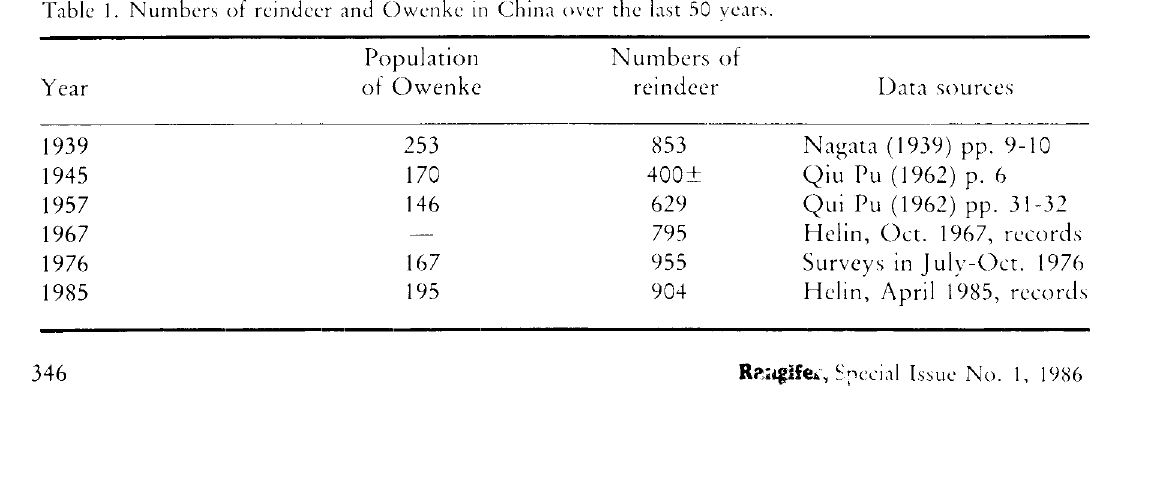
Table 1. Numbers of reindeer and Owenke in China over the last 50